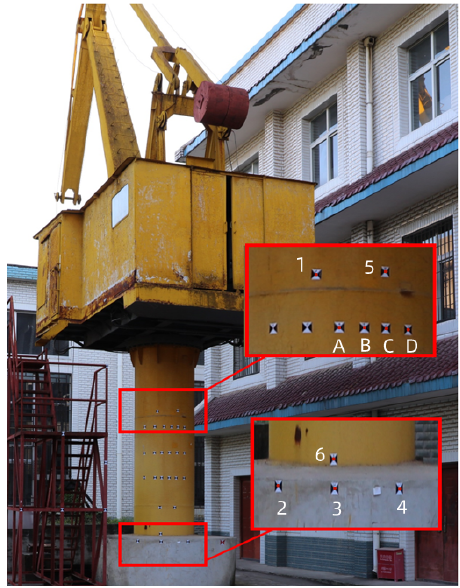
Figure 7. Points selection diagram of crane.